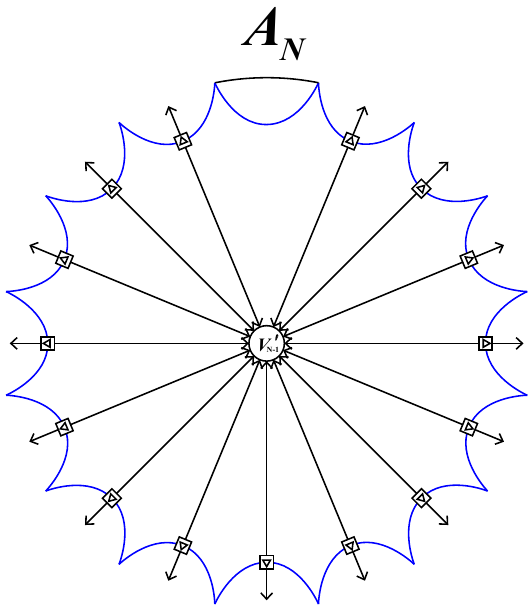
Figure 8 . The last step of the first